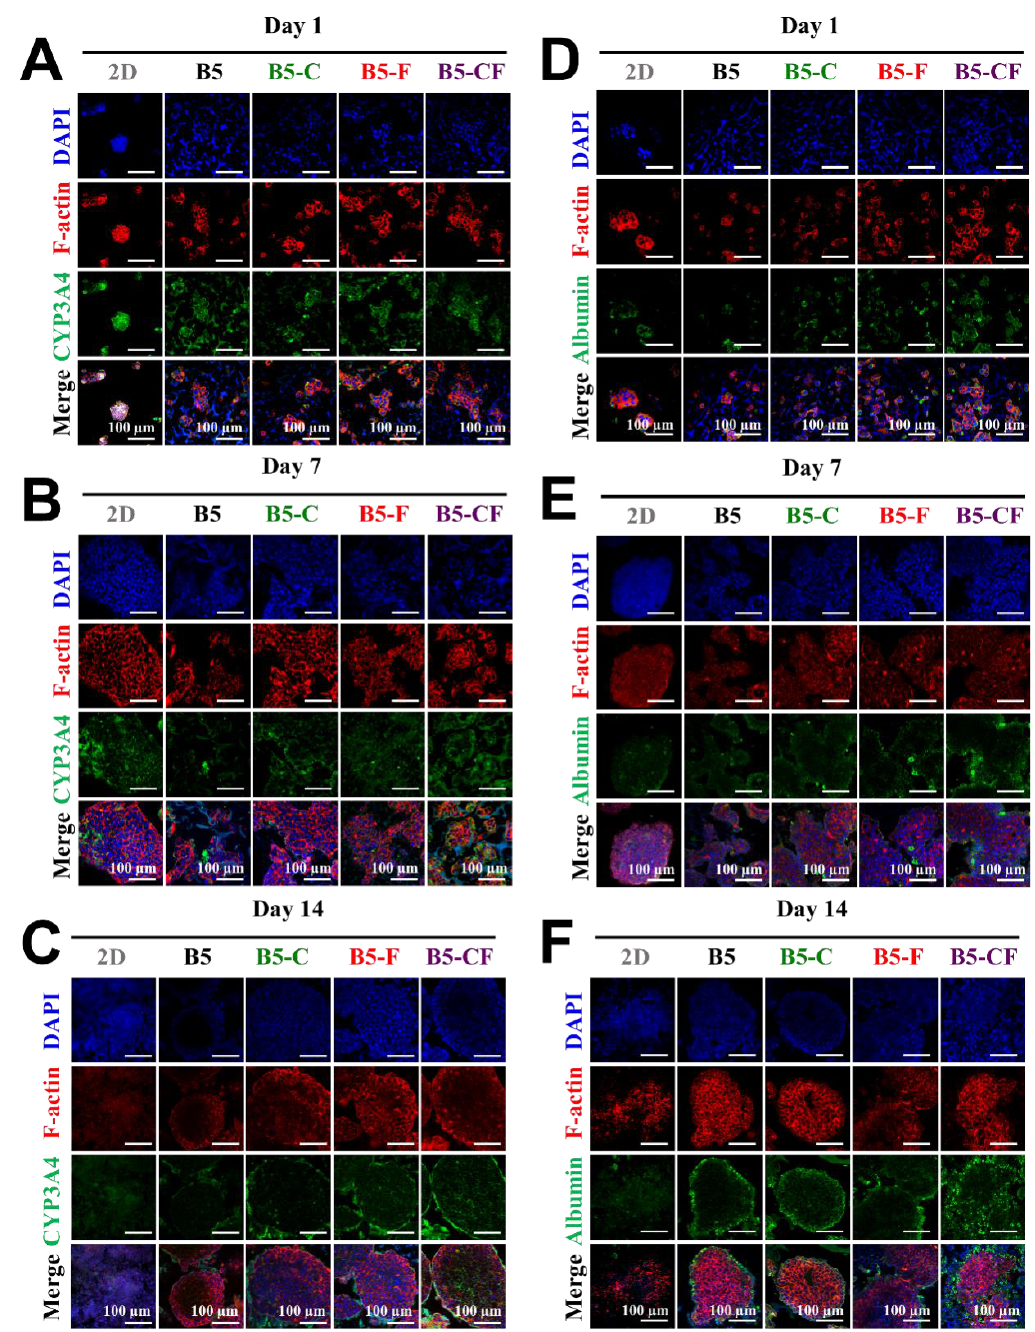
Figure 8. Evaluation of liver-specific functions of HepG2 cell constructs in 3D BSAMA cryogels and on 2D substrates at day 1, day 7, and day 14. ( A – C ) Confocal microscopic images of CYP3A4 immunostaining. Blue: nucleus; red: F-actin; green: CYP3A4. ( D – F ) Confocal microscopic images of albumin immunostaining. Blue: nucleus; red: F-actin; green: albumin. Cell constructs in B5-CF displayed the highest protein expression of both CYP3A4 and albumin. Scale bar: 100 μm.